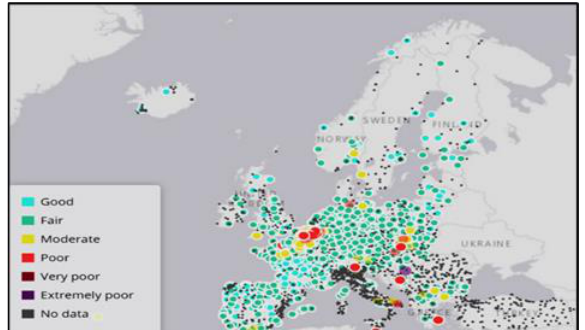
Figure 1. Current air quality (20 April